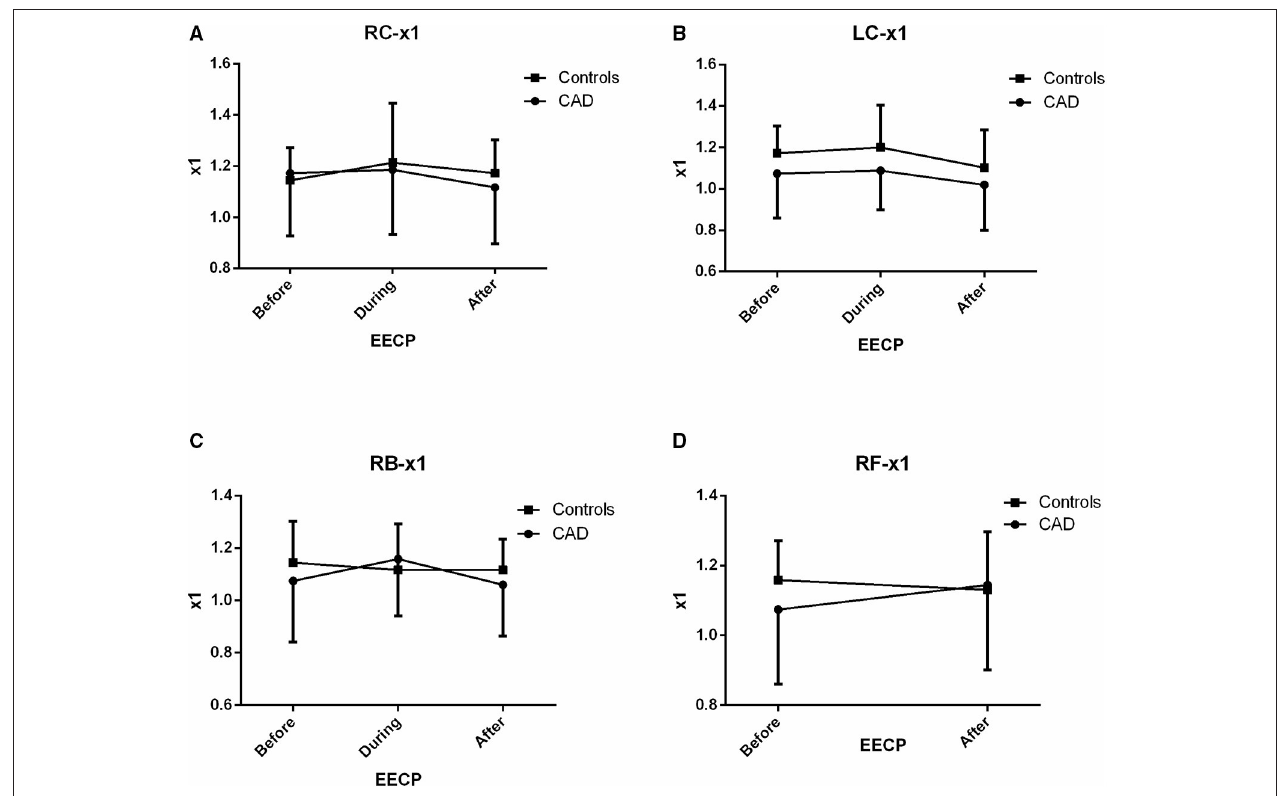
FIGURE 5 | Effect of EECP on the fundamental frequency (x1) of LC and RC arteries (A,B) , RB artery (C) , and RF artery (D) in patients with CAD and controls before, during and after 45-min